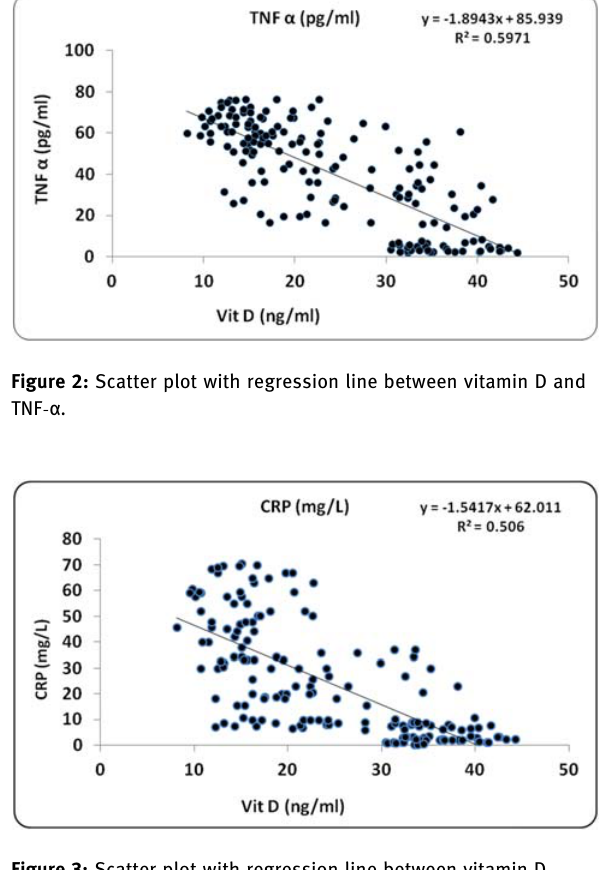
Figure 3: Scatter plot with regression line between vitamin D and